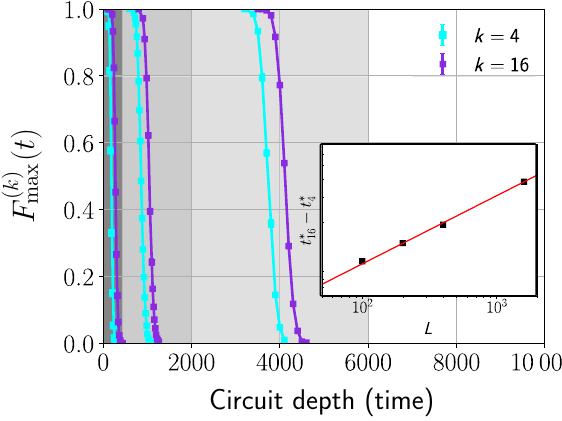
( t ) for k = 4 and k = 16 for FIG. 8. The maximum OTOC F ( k ) max different system sizes L = 100, 400, 1600 (shown left to right in separate shaded regions). The gap between the k = 4 and k = 16 wave fronts grows with system size. This gap size versus L is shown in the inset to grow like (cid:16) ∼ L α with α = 0.48 ( 1 ) .